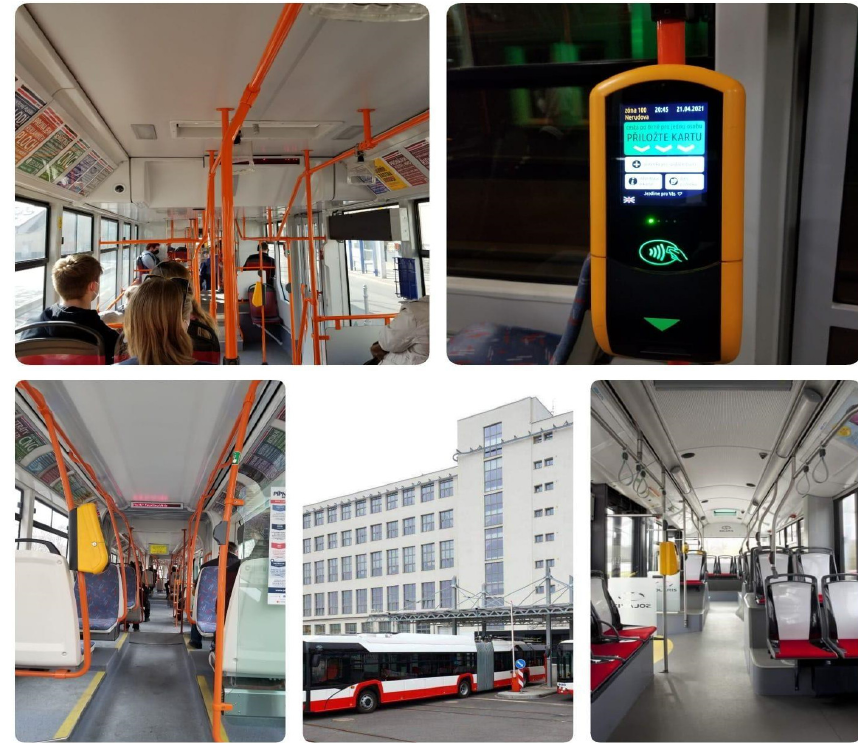
Figure 6. Trams and Buses, and internet payment options (Photos: Dastan Bamwesigye).